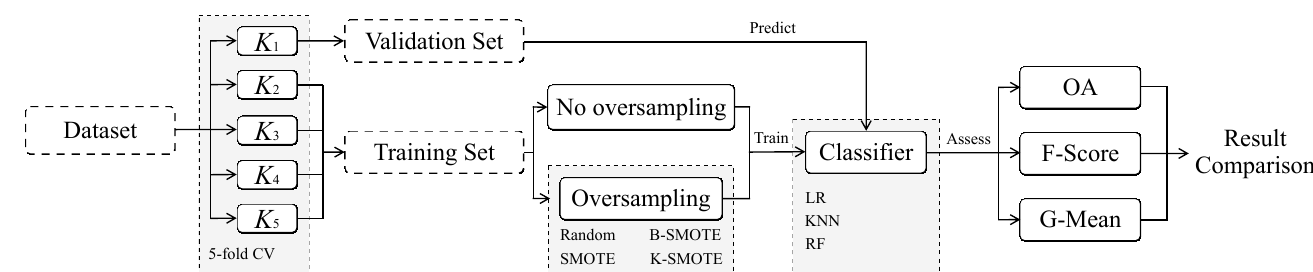
Figure 6: k -fold cross-validation strategy where k = 5 to train each model defined and save the averaged scores of each split.